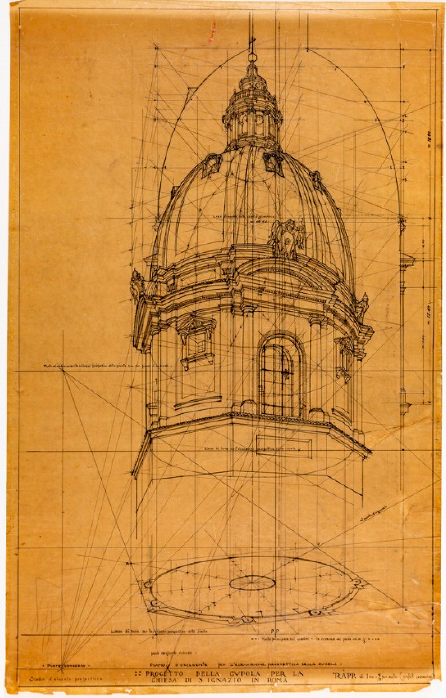
Figure 9. Armando Brasini, 1918–1921, Project for the dome of St Ignatius, Drawing Matter Collec- tions (Collection No.